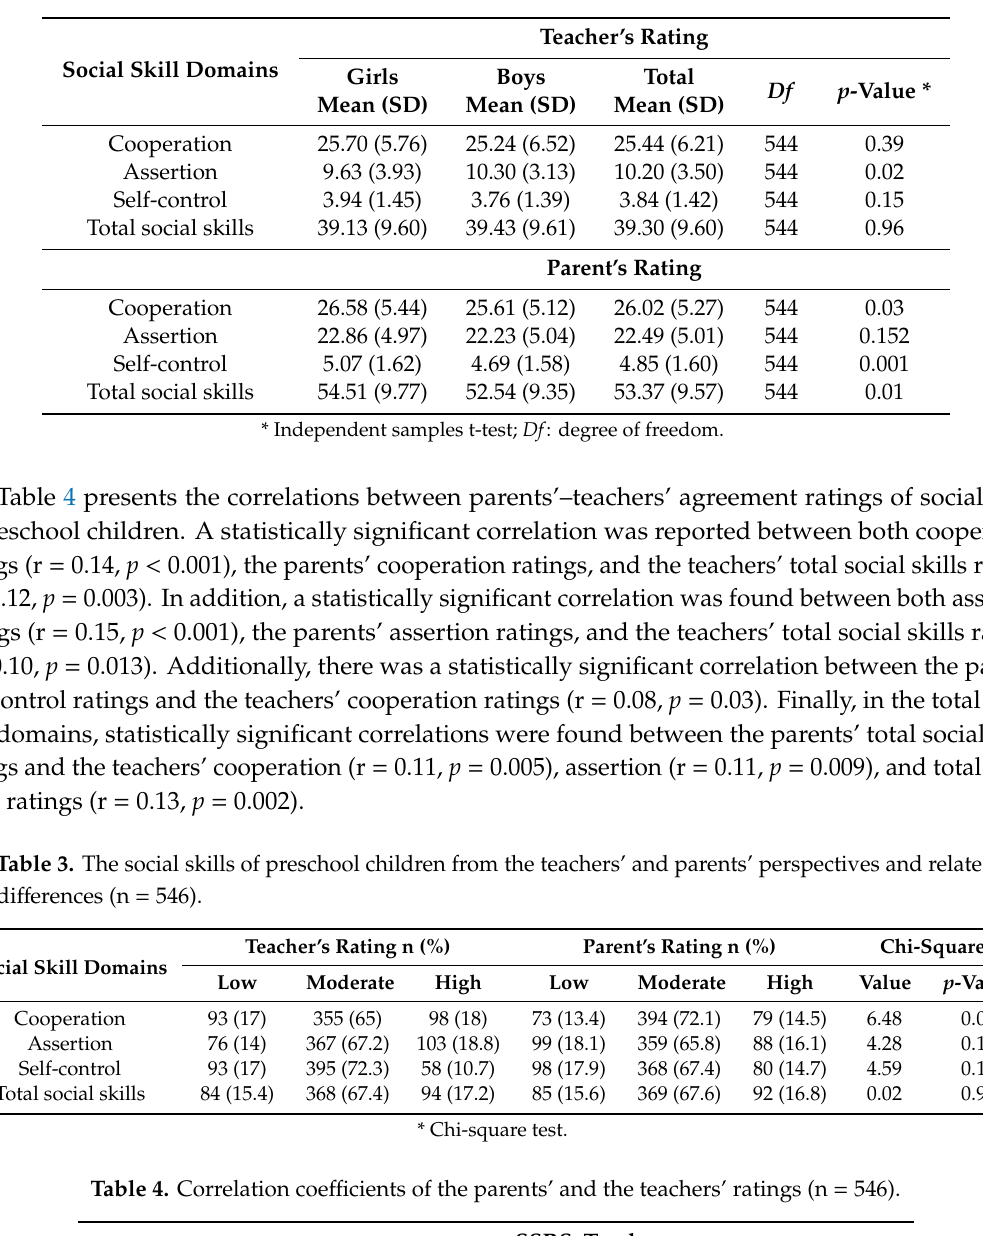
Table 2. Gender di ff erences in social skills from the teachers’ and parents’ perspectives.